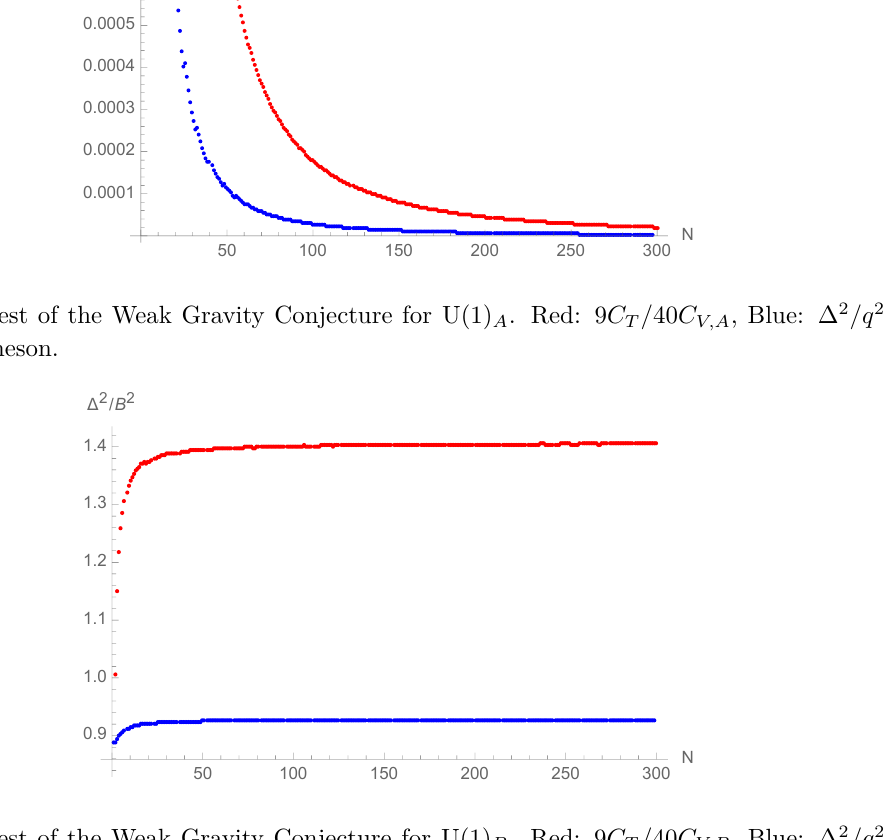
Figure 5 . Test of the Weak Gravity Conjecture for U(1) B . Red: 9 C T / 40 C V,B , Blue: ∆ 2 /q 2 for the baryon operators charged under U(1) B